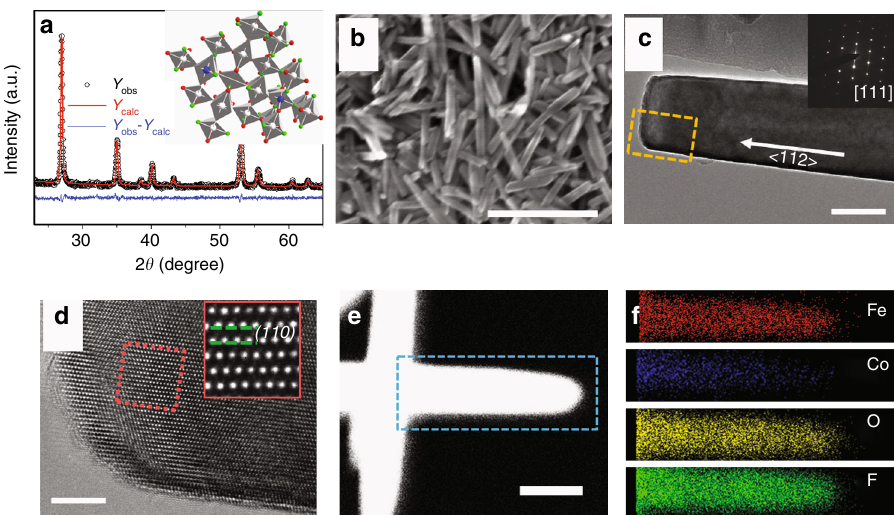
Fig. 1 Structural and morphological characterization of Fe 0.9 Co 0.1 OF. a Rietveld re fi nement showing data points ( Y obs , black circles), calculated pro fi le ( Y calc , red line), and difference pro fi le (blue line), as indicated. Re fi ned parameters: a = 4.68(6) Å, c = 3.06(6) Å, which are slightly larger than those of FeOF ( a = 4.647 Å, c = 3.048 Å). b SEM images of the Fe 0.9 Co 0.1 OF nanorods; c , d TEM and HRTEM images of Fe 0.9 Co 0.1 OF; e , f STEM-HAADF image of Fe 0.9 Co 0.1 OF nanorod and STEM-EDS elemental mapping of Fe, Co, O, and F. Inset of a : the crystal structure of Fe 0.9 Co 0.1 OF. The insets of c : corresponding SAED pattern. The insets of d : enlargement HRTEM image of the HRTEM image. The rectangle in e denotes the EDS mapping area in f . Scale bar in b – e is 400, 50, 5, and 50 nm,